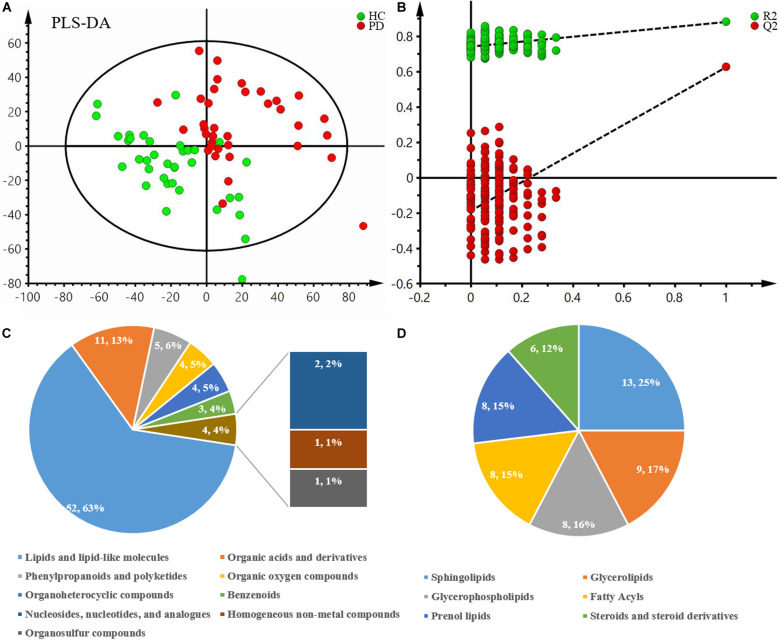
Multivariate statistical analysis of metabolomics and the classification of differentially expressed metabolites between PD patients and healthy controls. (A) PLS-DA score plot derived from liquid chromatography-mass spectrometry-based metabolomics analysis of PD patients and healthy controls. (B) Statistical validation of the PLS-DA model by permutation testing with 200 iterations. (C) Pie chart of the superclass of chemical taxonomy based on the annotations from Human Metabolome Database. (D) Pie chart of the further classification of lipids and lipid-like molecules. PD, Parkinson’s disease; HC, healthy control; PLS-DA, partial least squares-discriminant analysis.